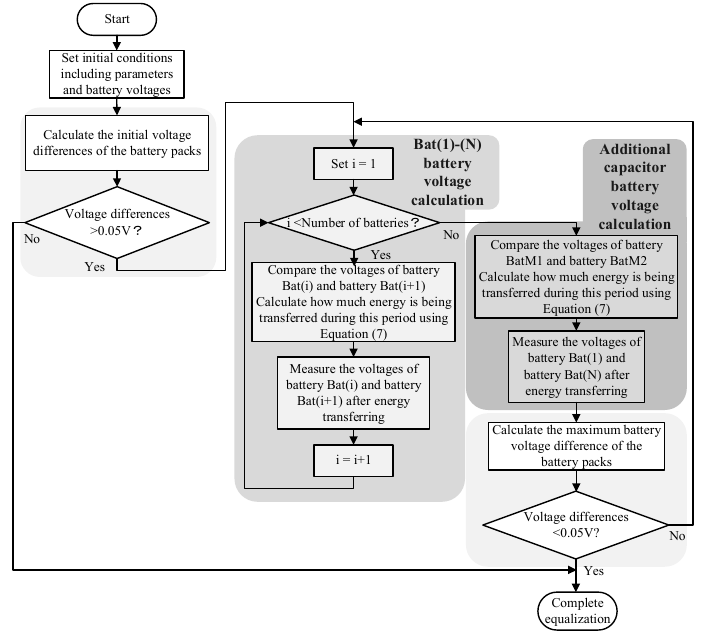
Figure 14. Flowchart of the chain structure of SC-based BE type II.